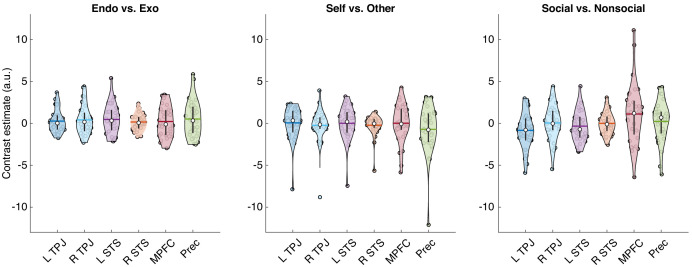
Univariate fMRI results within ROIs.The difference in average activity across all voxels within each ROI, for the endogenous-versus-exogenous, self-versus-other, and social-versus-nonsocial contrasts, are shown. Violin plot showing the mean (colored horizontal line) and median (white circle) contrast estimate, interquartile range (black vertical line), a kernel density estimation (shaded area), and individual data points. None of the contrasts were statistically significant after controlling for multiple comparisons across all six ROIs (all FDR-corrected ps >0.21).